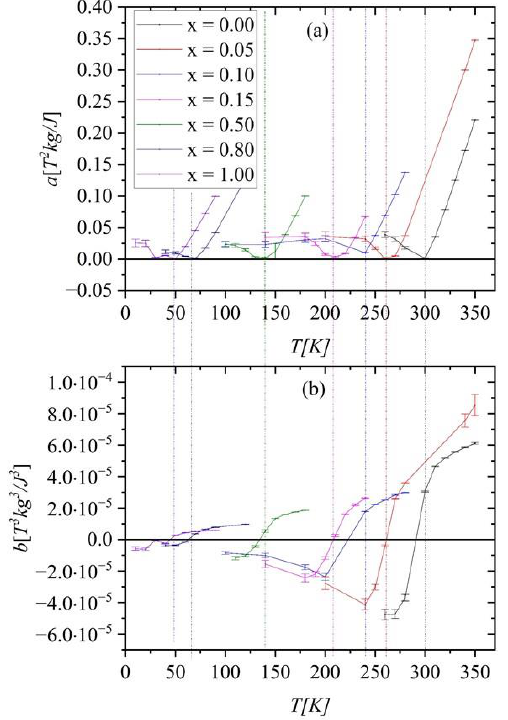
Figure 8. The temperature dependence of Landau coefficients a ( T ) and b ( T )—figures ( a ) and ( b ), respectively. Vertical lines indicate transition temperatures ( T C ) for alloys with different x.